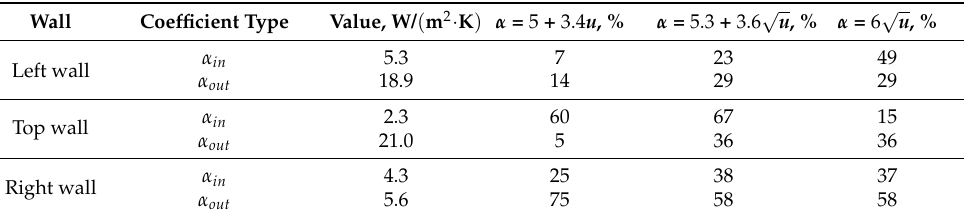
Table 4. Errors in the values of the average heat transfer coefficients obtained by the numerical method and by applied formulas obtained